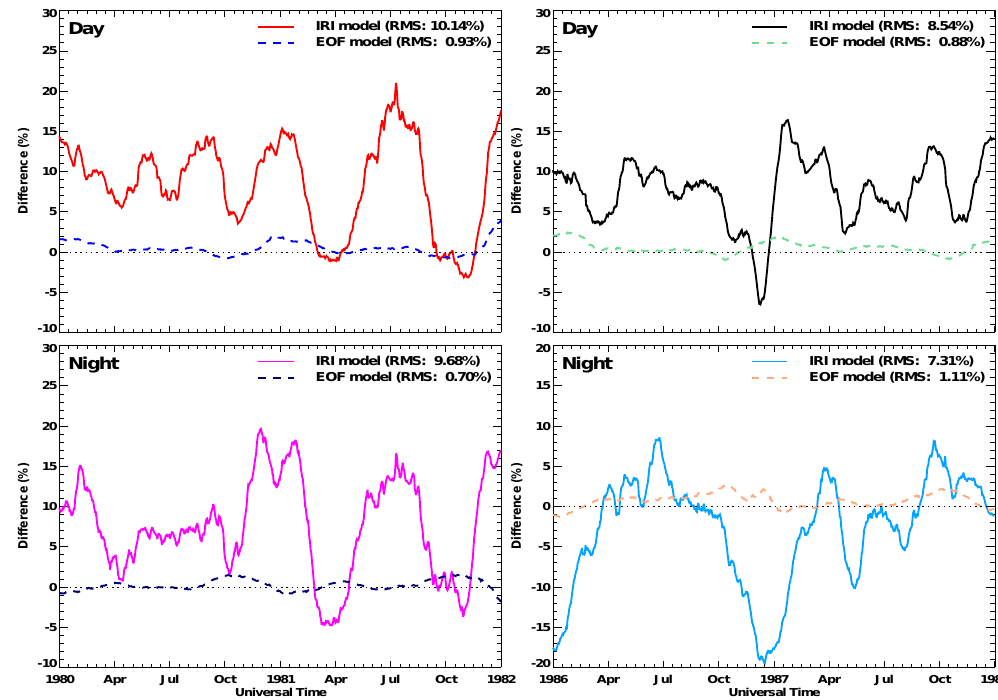
Fig. 10. Long-term variation of relative errors and relative mean square errors between model and the observatioanl